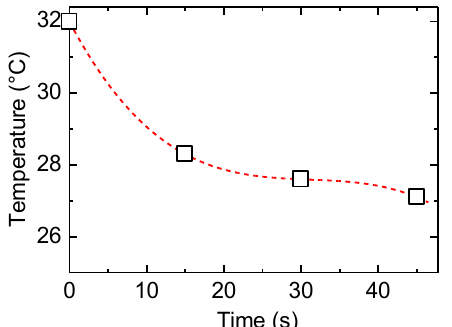
Figure 7. Surface thermographic images of PAZ/Hb accompanied by heat discharge after IR heating.